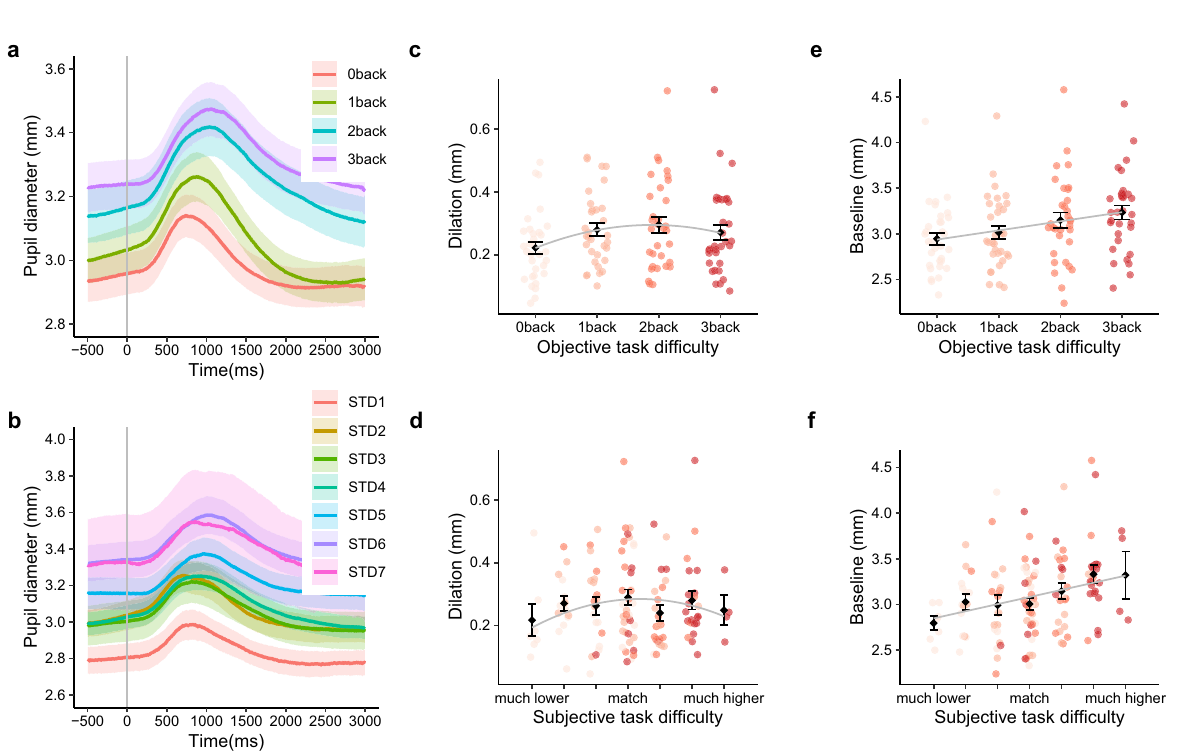
Figure 2. Pupil diameter changes as function of task difficulty. ( a ) Grand averaged continuous pupil diameter in four n-back tasks. ( b ) Grand averaged continuous pupil diameter in seven subjective task difficulty groups ( STD subjective task difficulty). ( c ) Quadratic relationship between objective task difficulty and stimuli-evoked pupil dilation. ( d ) Quadratic relationship between subjective task difficulty and stimuli-evoked pupil dilation. ( e ) Linear relationship between objective task difficulty and baseline pupil diameter. ( f ) Linear relationship between subjective task difficulty and baseline pupil diameter. The means ± standard errors are